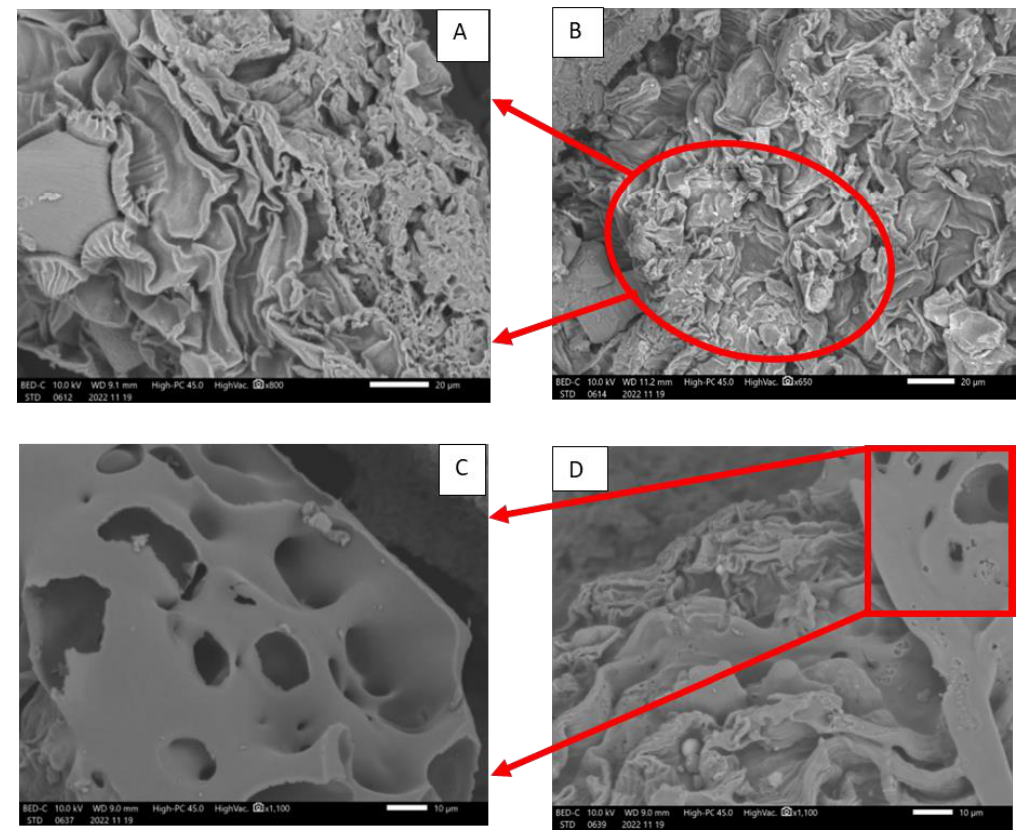
Figure 2. SEM images of Raw-RGL ( A , B ) and AC-RGL ( C , D ) adsorbents.